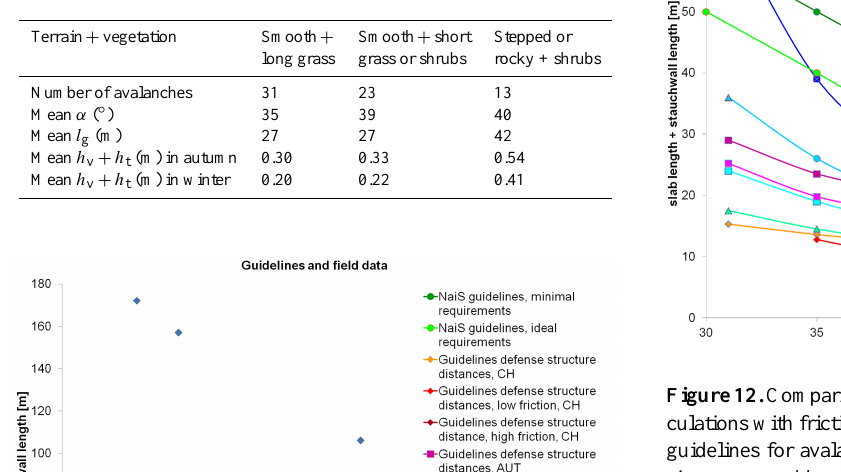
Table 3. Vegetation and terrain combined into three categories. The least roughness was observed for smooth terrain with long grass and the roughest surface was observed when stepped or rocky terrain was covered with shrubs. The second category was smooth terrain covered with short upright grass or shrubs.